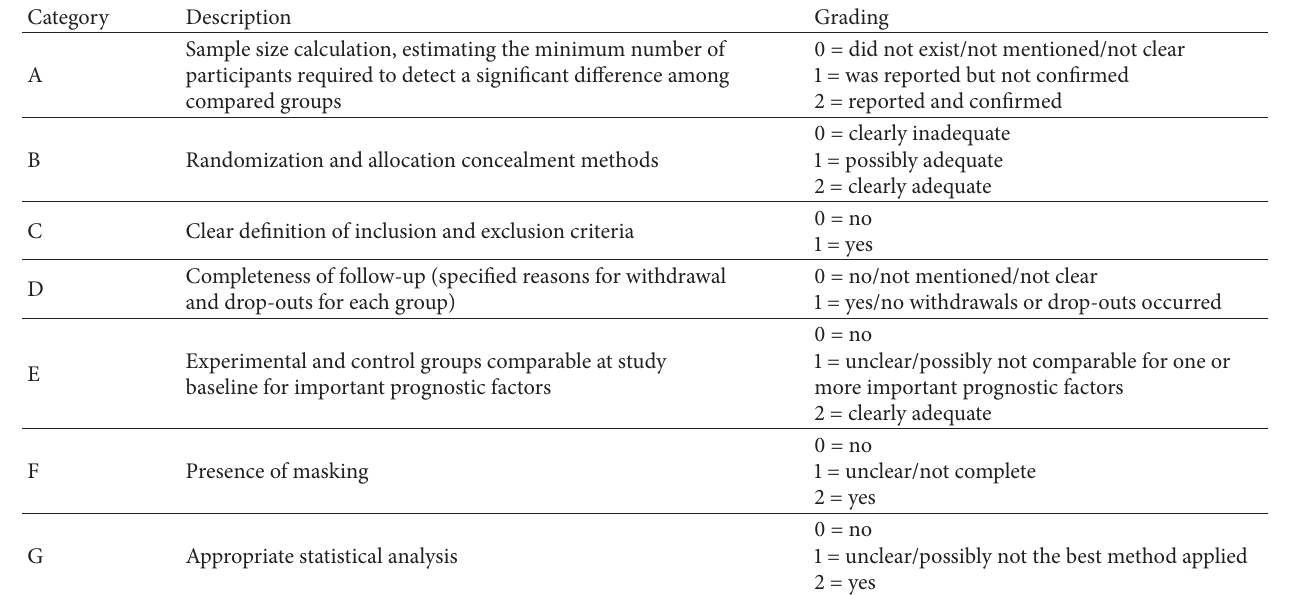
Table 1: Grid used for assessing the papers (adapted from